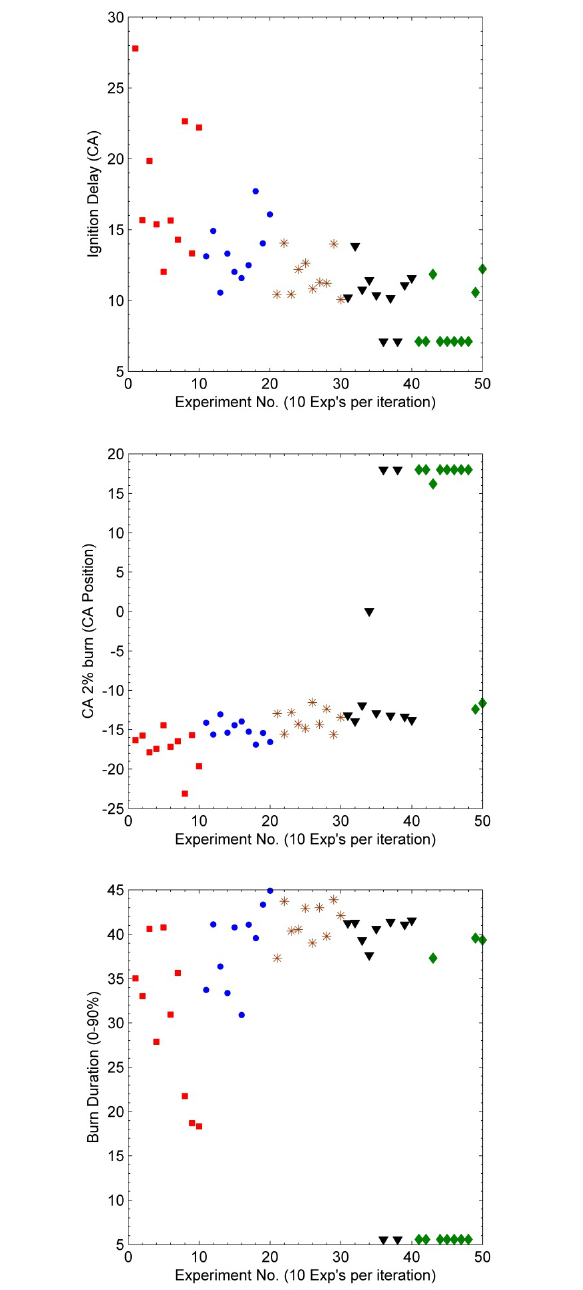
Fig. 10: Progression of combustion parameters with the optimization